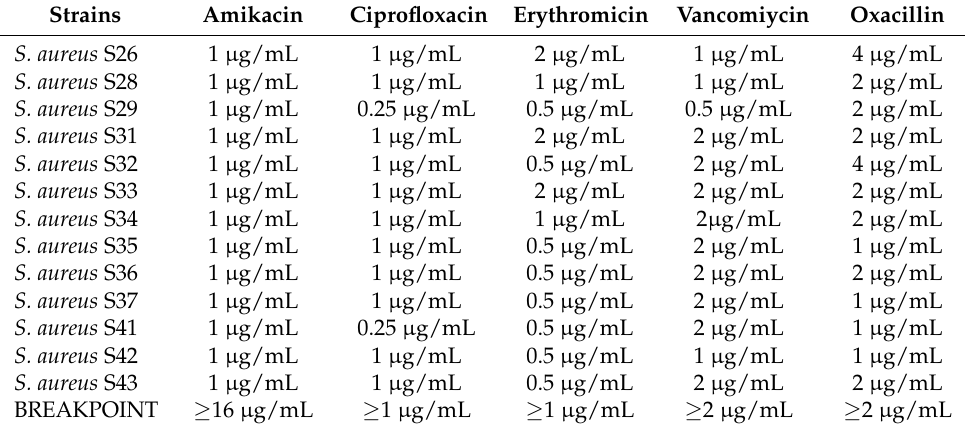
Table 3. MIC values for Staphylococcus aureus strains and their Break Point